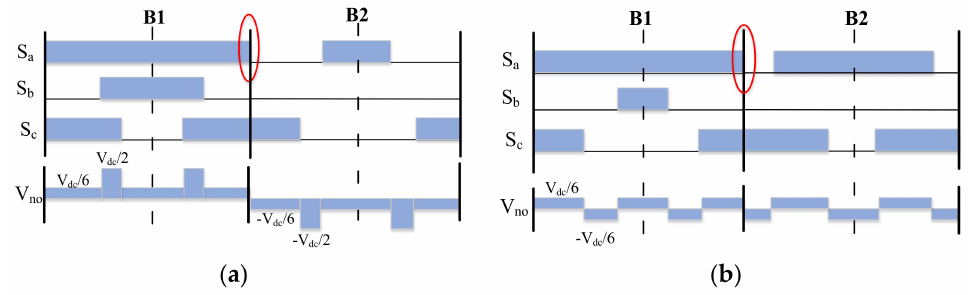
Figure 5. Discontinuous switching between two different sectors in TSPWM: ( a ) low region; ( b ) high region.